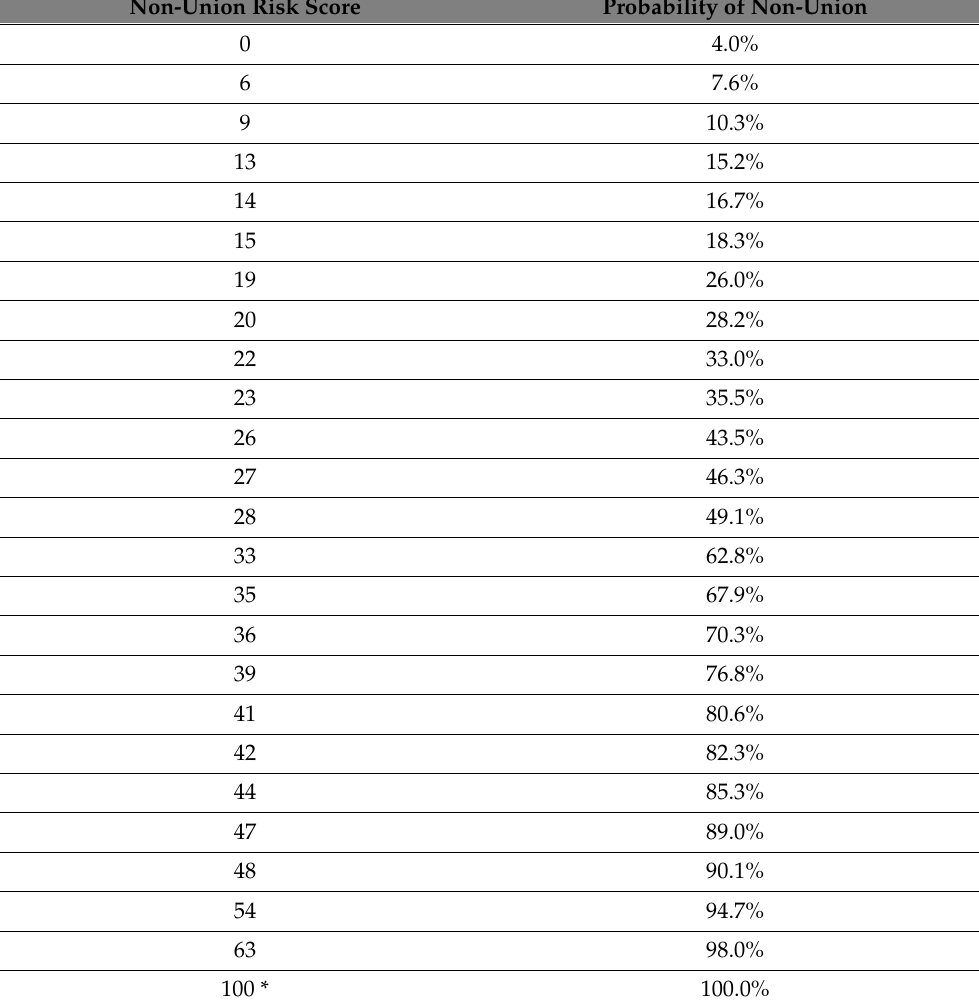
Table 4. Non-union risk score and corresponding probability of